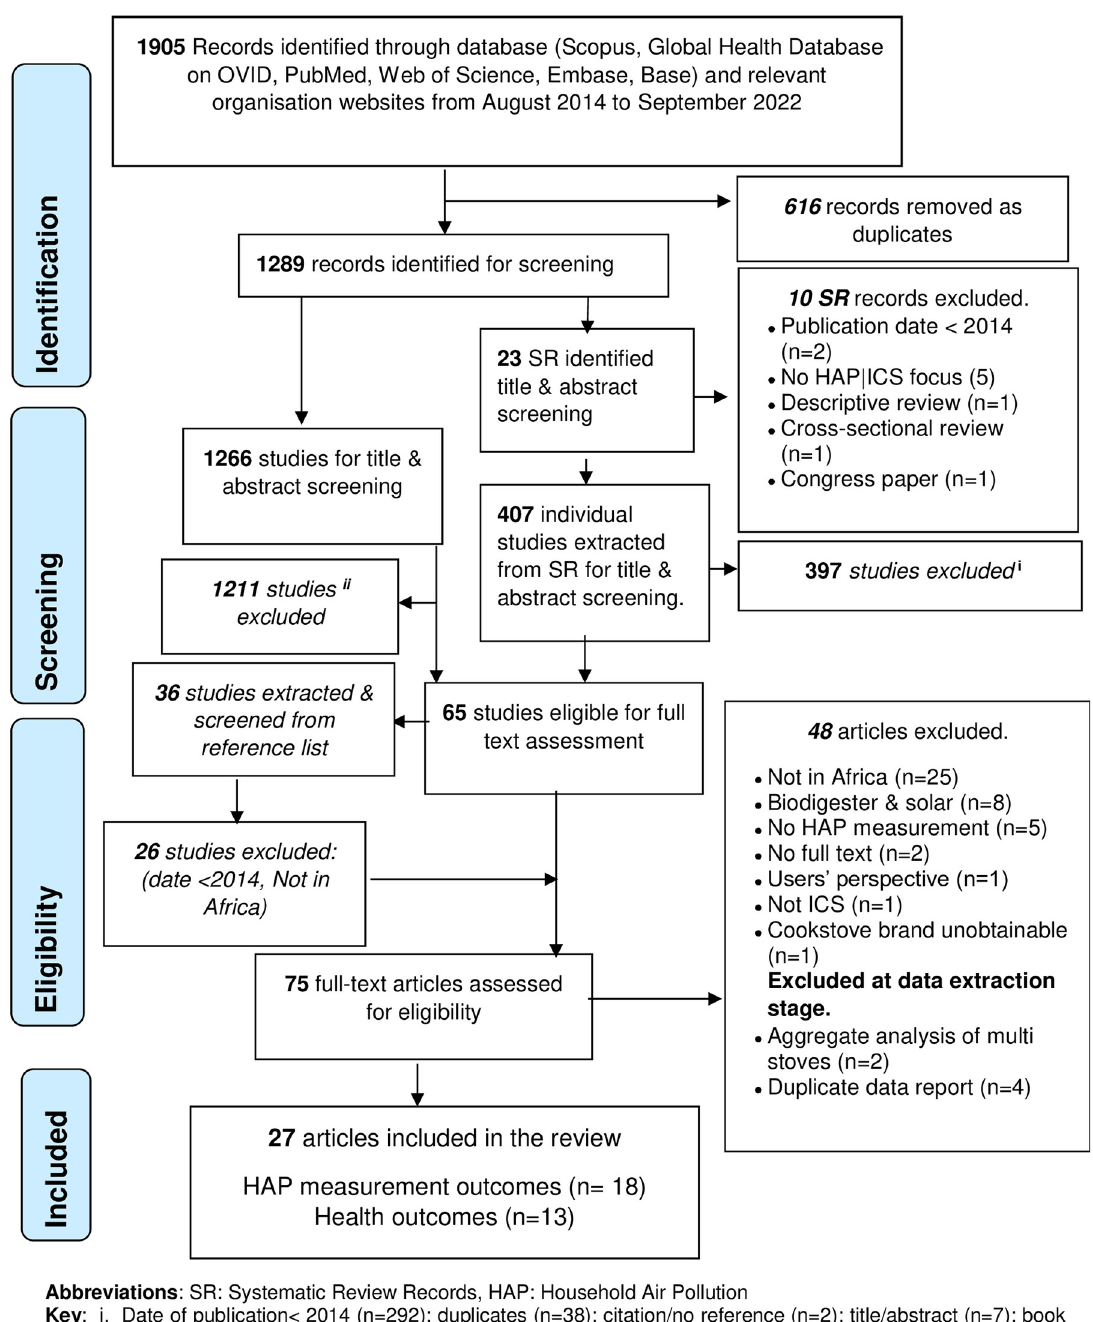
Fig 2. PRISMA flow diagram of selection of studies included in HAP and health